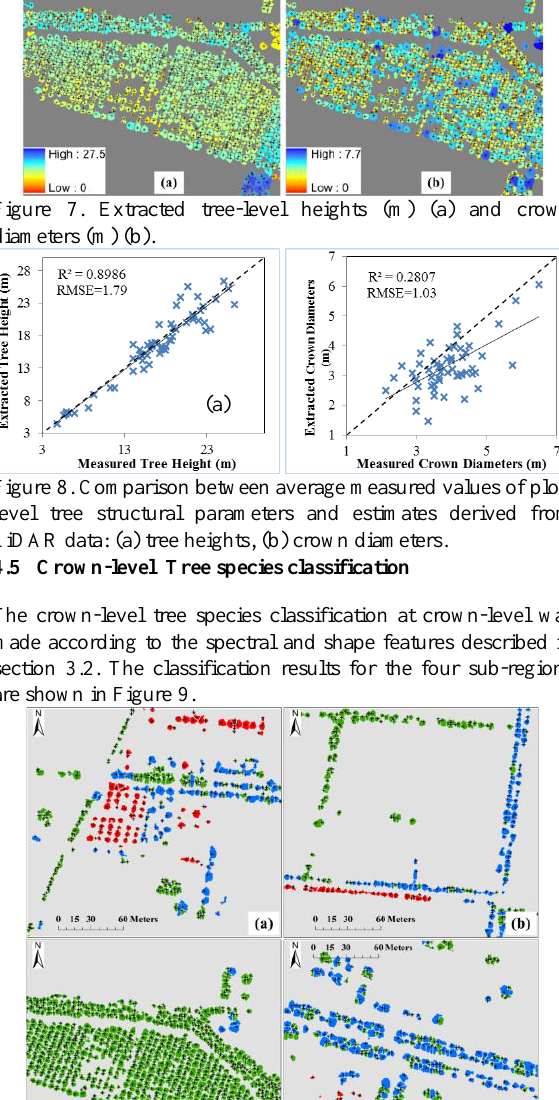
Figure 7. Extracted tree-level heights (m) (a) and crown diameters (m) (b).